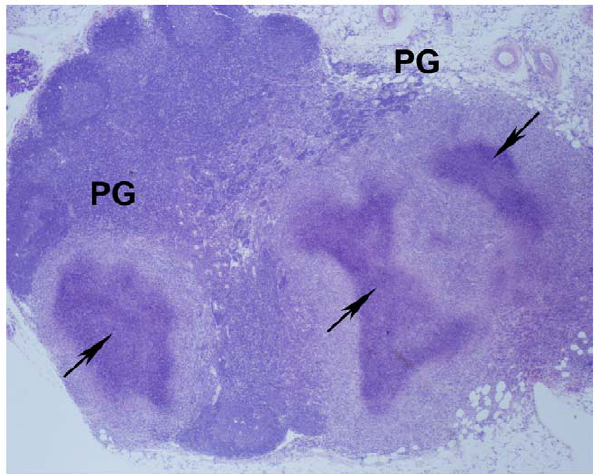
Figure 1. Pyogranulomatous inflammation of the small intes- tine. Cross section showing diffuse pyogranulomatous inflammation involving the mucosa and muscularis: Areas of highly populated pyogranulomous inflammation (PG), overlying villi of the mucosa are shortened (white arrow) and fused (black arrow) and the crypts (C) are hyperplastic (shown at 4X magnification). Details of processing and staining of the tissue are provided in Materials and Methods.